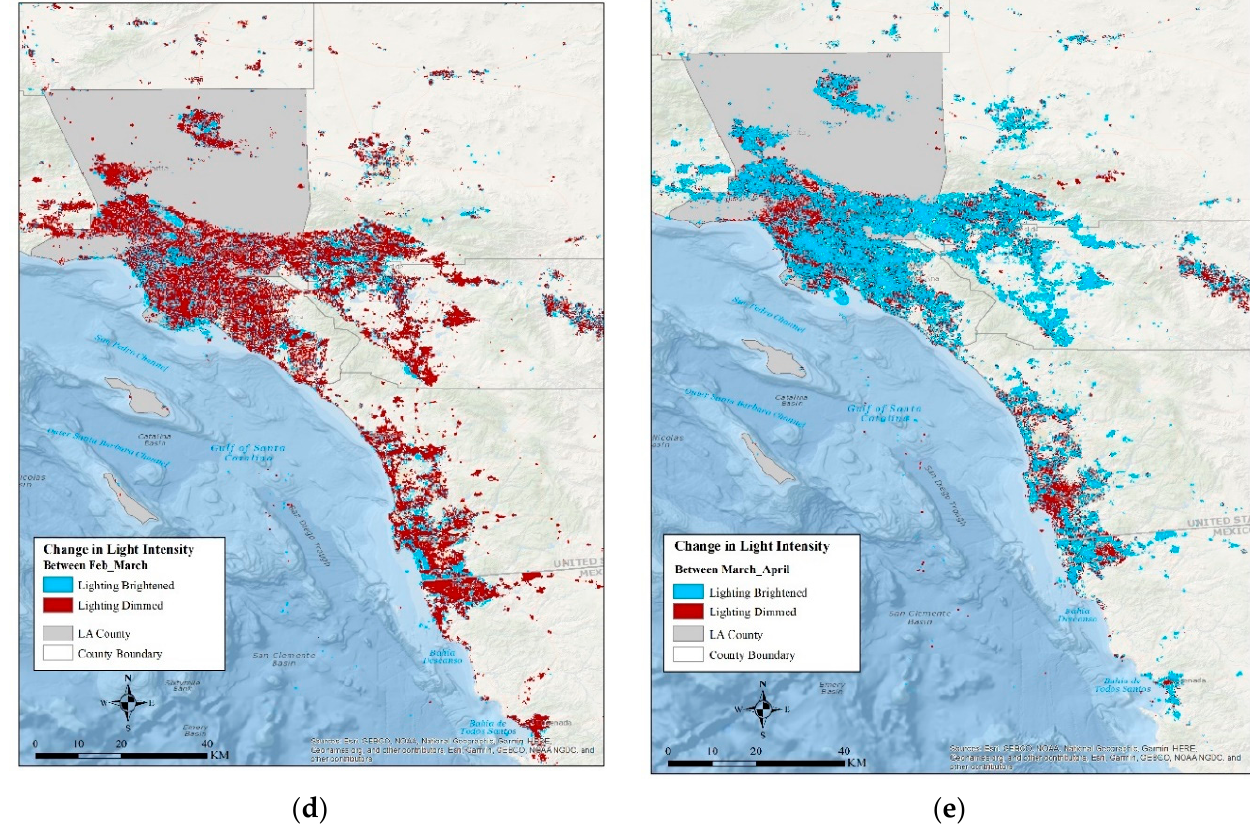
Figure 18. Nighttime light (NTL) intensity distribution from VIIRS for Los Angeles in February ( a ), March ( b ), April ( c ); change in NTL intensity in LA between February and March ( d ) and between March and April ( e ).